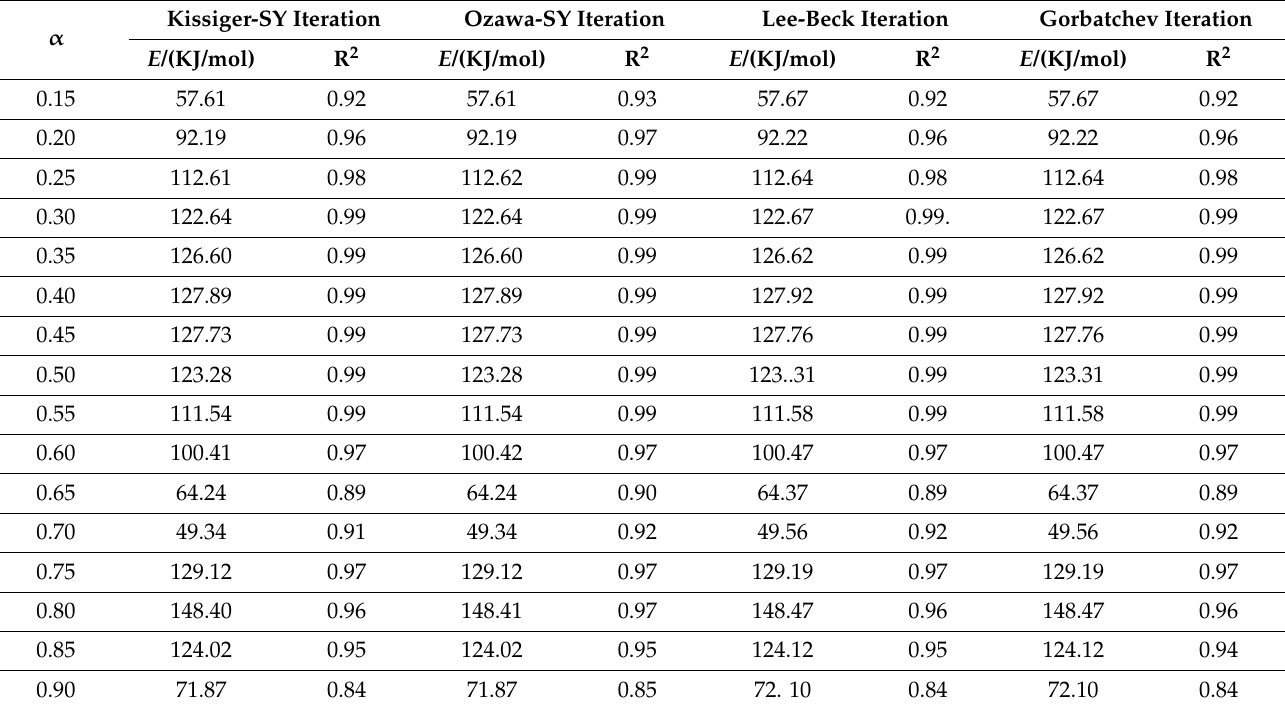
Figure 3. Linear regression fitting diagram of equal conversion method of EP/15% F-Lignin@HKUST- 1 based on four temperature approximation. Table 2. Activation energy of Lignin at different conversions.